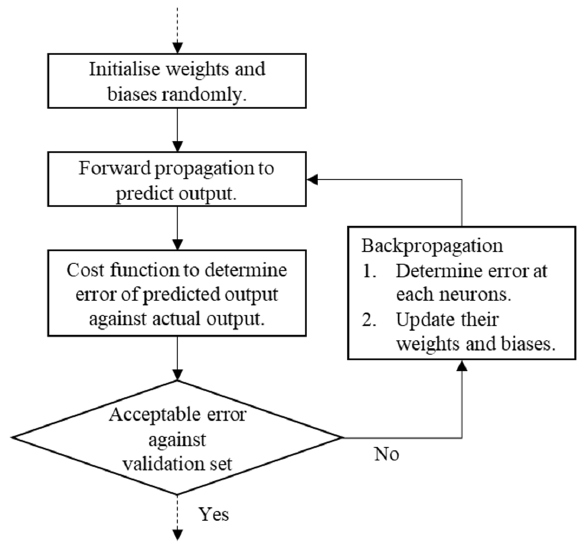
Figure 6. FFNN training process.